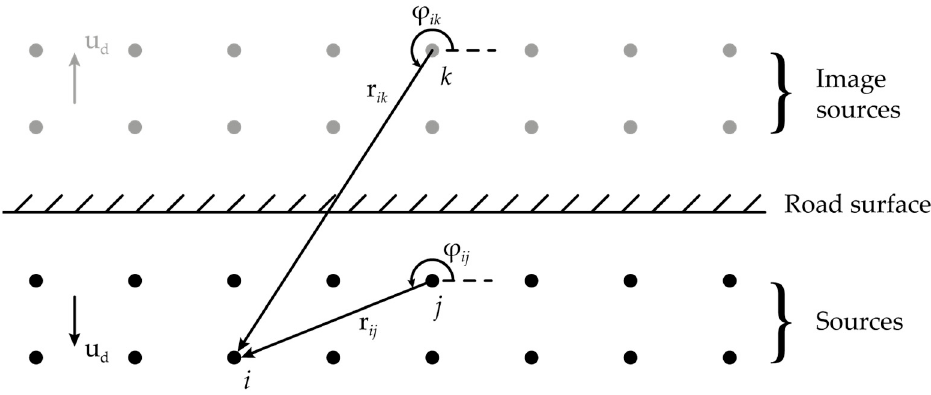
Figure 5. Conceptual illustration of the brine temperature model with the 16 pipe segments embedded in the roadbed. Infiltration into the roadbed is indicated by the Darcy flow vector u d . The image sources and Darcy flow vector are shown in grey.